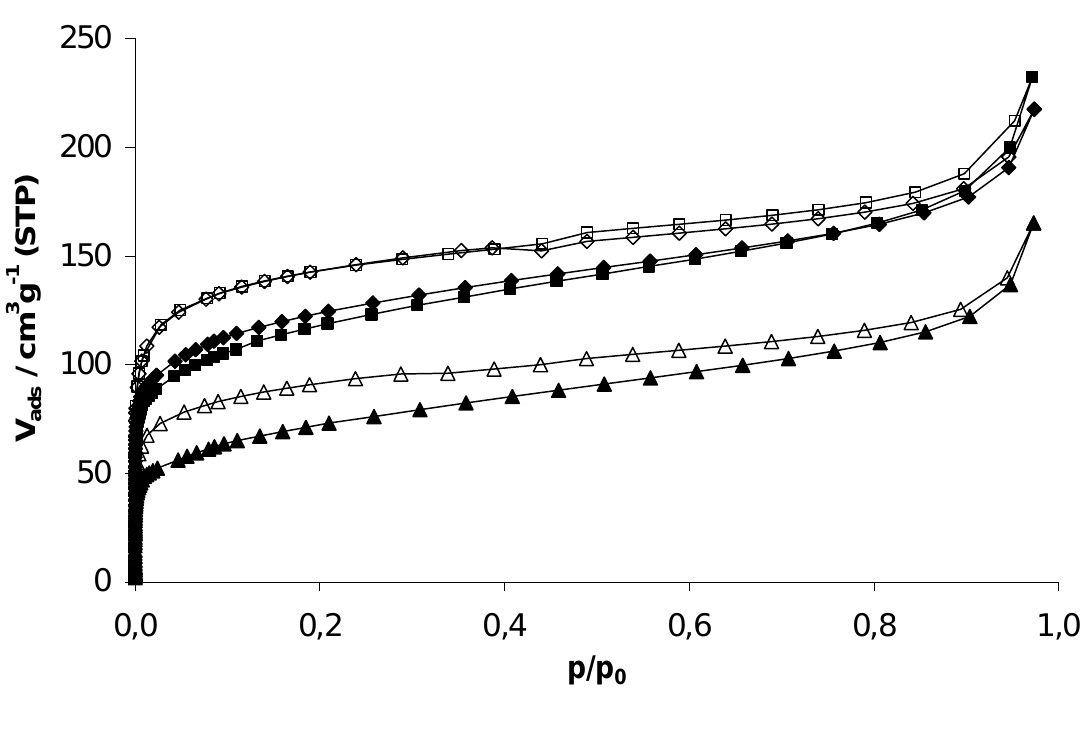
Figure 5. Nitrogen physisorption isotherms of EOF-3 (diamonds), -4 (squares) and -5 (triangles) measured at 77